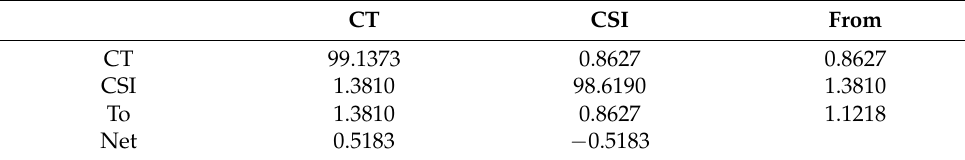
Table 2. Static risk spillover relationship between the carbon and overall